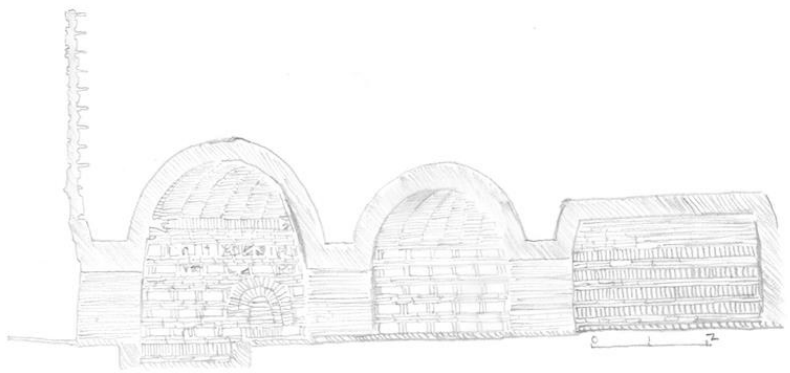
Figure 4. Cross section, Jiayuguan M6, brick, Wei-Jin period, 220–317 CE, after Gansusheng Bowuguan et al. (1985, Figure 15).